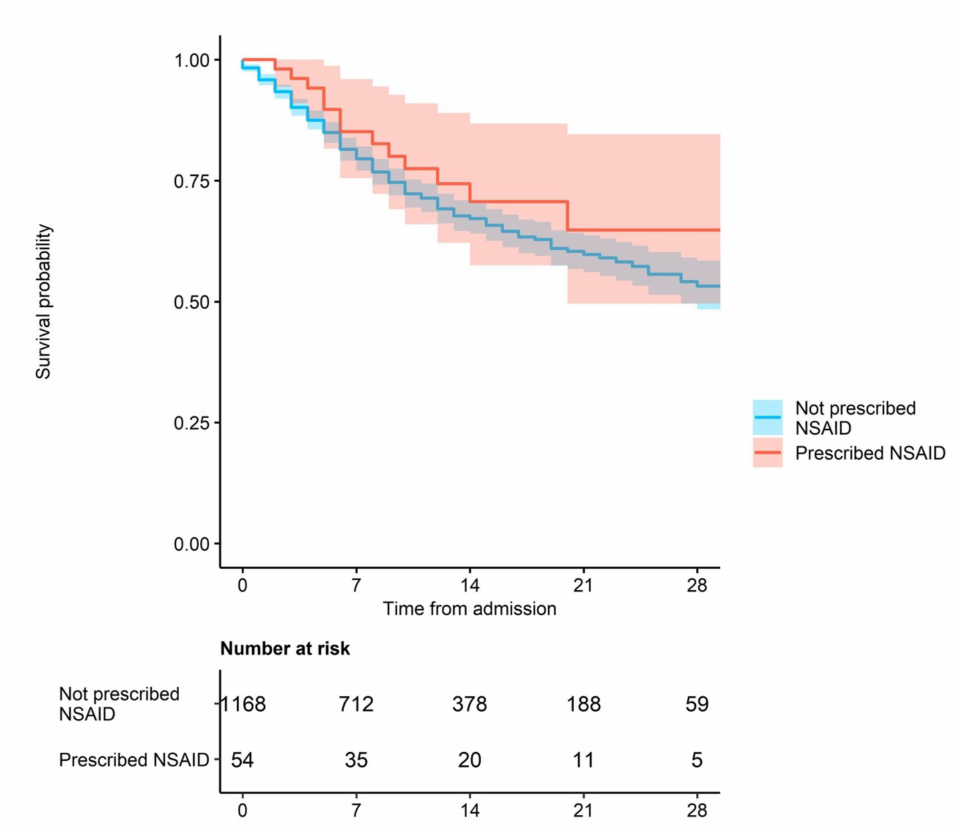
Figure 1. NSAID use and mortality (shaded areas indicate 95% confidence intervals). Table 2. Time to mortality. Crude and multivariable